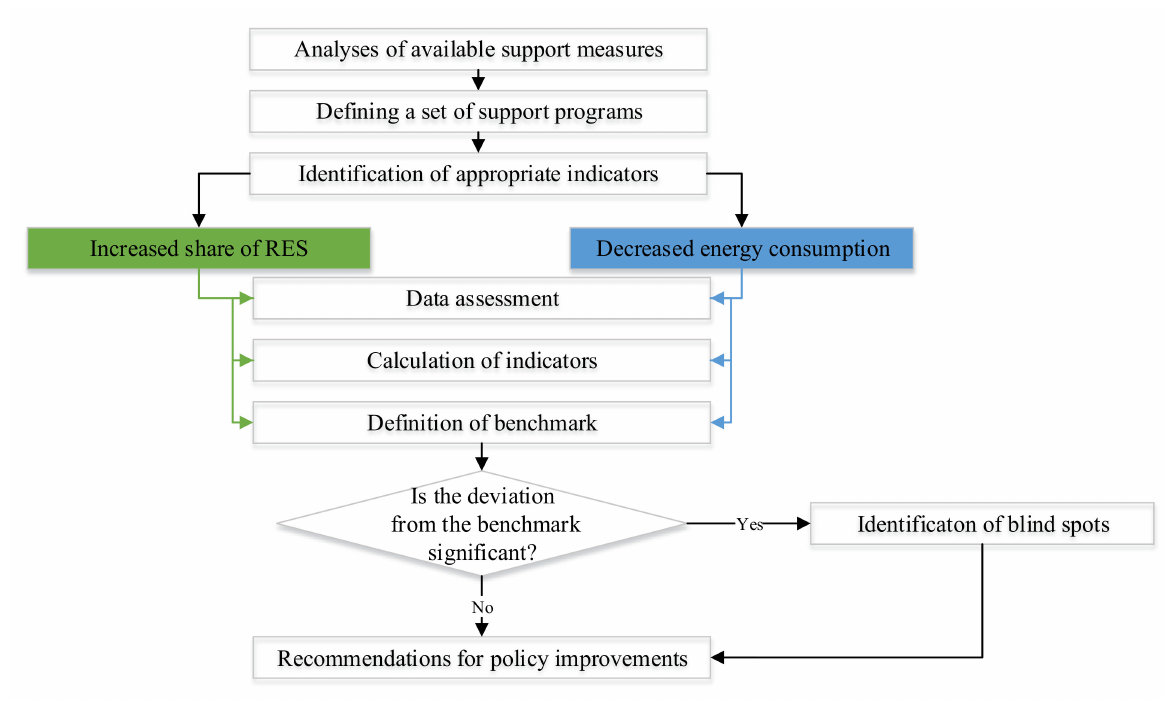
Figure 1. Main steps of the